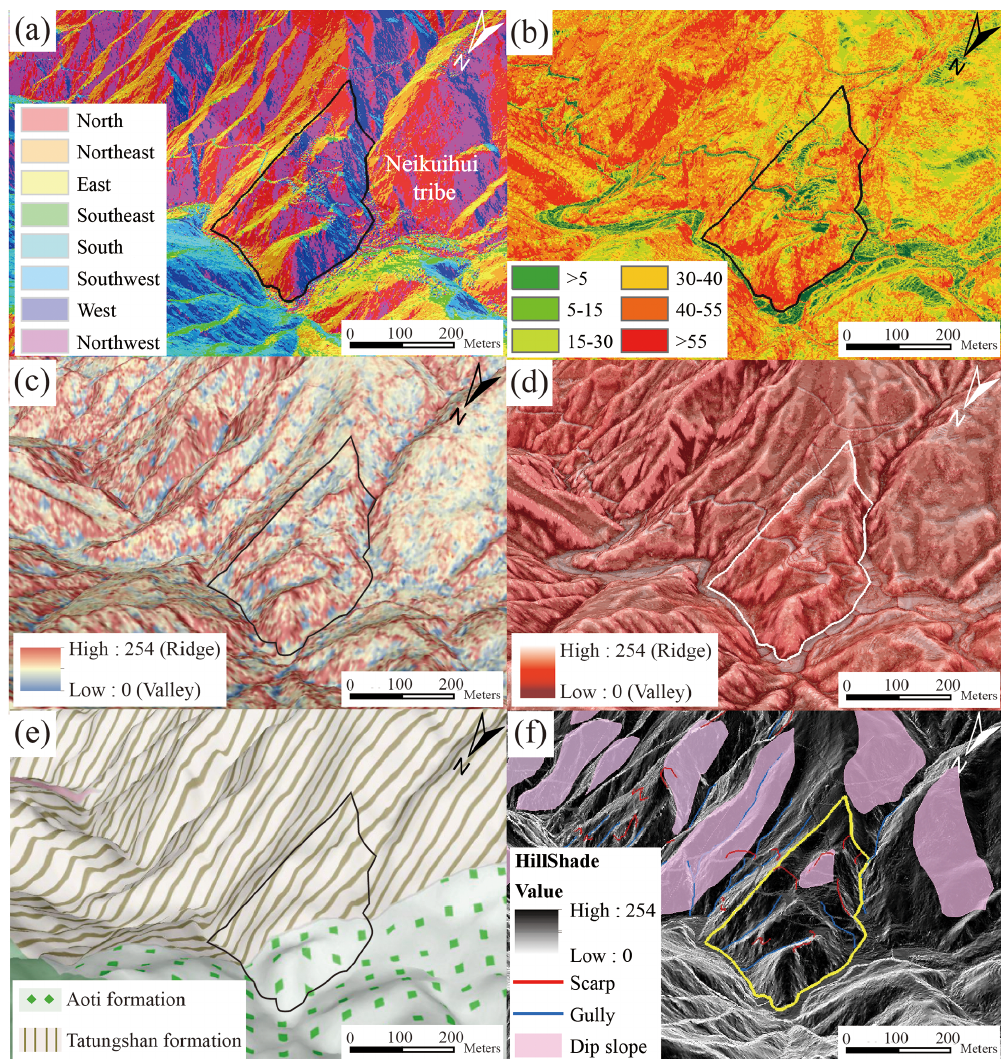
Figure 2. Basic geology and environment of the Neikuihui tribe: (a) slope aspect (modified from 2020 data from the Department of Lands, Ministry of the Interior, for research purposes only); (b) slope map (modified from 2020 data from the Department of Lands, Ministry of the Interior, for research purposes only); (c) CS map (modified from 2020 data from the Department of Lands, Ministry of the Interior, for re- search purposes only); (d) relief map (modified from 2020 data from the Department of Lands, Ministry of the Interior, for research purposes only); (e) 1 : 250000 geological map (modified from Central Geological Survey, 2020); and (f) geologically sensitive area distribution map (modified from 2020 data from the Department of Lands, Ministry of the Interior, for research purposes only) with a hillshade-based map; aerial: ESRI ArcGIS